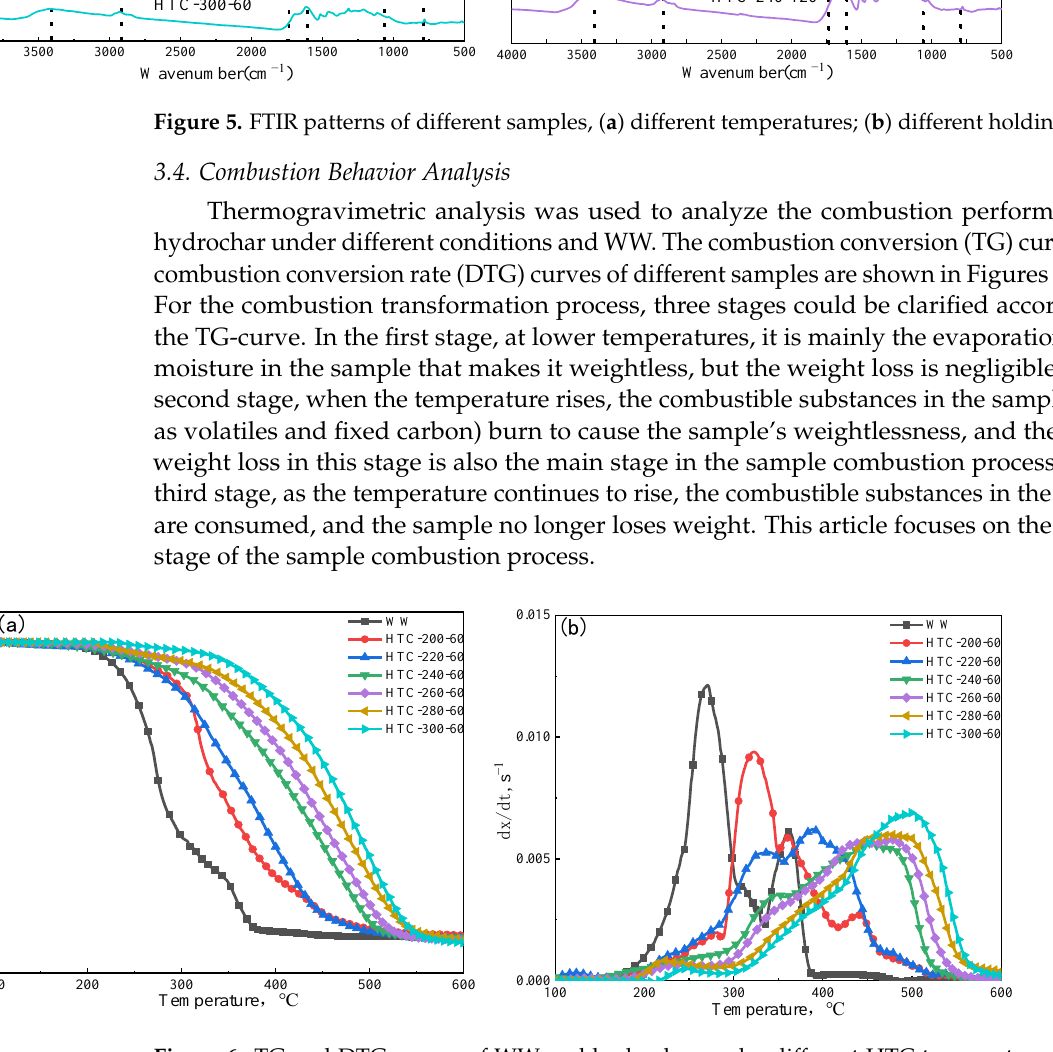
Temperature ， ℃ Figure 7. TG and DTG curves of hydrochar under different holding times: ( a ) TG curves; ( b ) DTG curves The combustion characteristic parameters (Table 3) of the samples were extracted to further analyze the combustion characteristics of hydrochar [41]. With an increase in the HTC temperature and holding time, the T i , T f , T M 1 , and T M 2 of hydrochar gradually in- creased, as shown in Table 3. When the HTC temperature exceeds 240 °C and the holding time exceeds 60 min, T M 1 disappears; that is, the first combustion characteristic peak dis- appears. In comparing the R M 1 and R M 2 values of different samples, it can be observed that as the HTC temperature increases as the holding time increases, R M 1 gradually decreases until it disappears, and the difference between R M 1 and R M 2 gradually decreases. Further, with the disappearance of R M 1 and the first characteristic peak of combustion, the R M 2 value gradually increases, which means that the start combustion temperature of the hy- drochar increases, which is good for the storage and transportation of the product. Table 3. Combustion characteristic parameters of different samples Sample